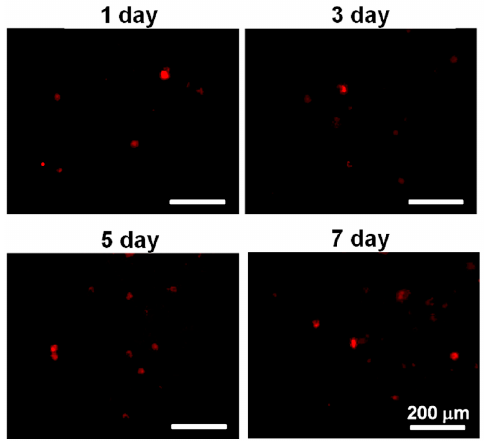
Figure 7. The images of PKH26-stained cells in PU4 hydrogel at the first, third, fifth and seventh day of culture.